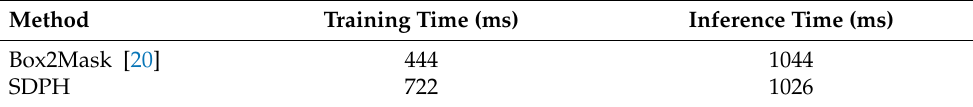
Table 4. Comparison of the average computation time in milliseconds per scan on ScanNet-v2. The running time was measured in the same environment. Note that a post-processing step was implemented to cluster points into instances in